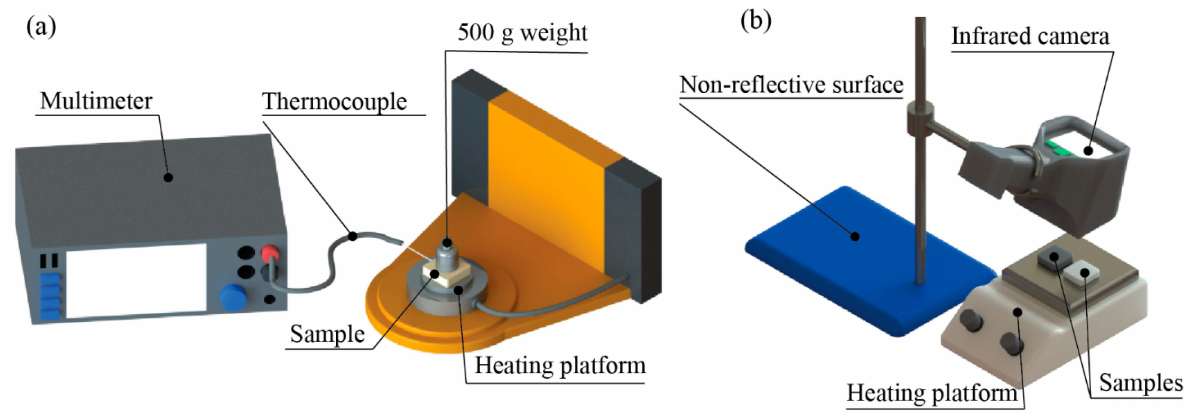
Figure 2. Experiment setups for ( a ) collecting numerical temperature response data and ( b ) thermal images for temperature change.